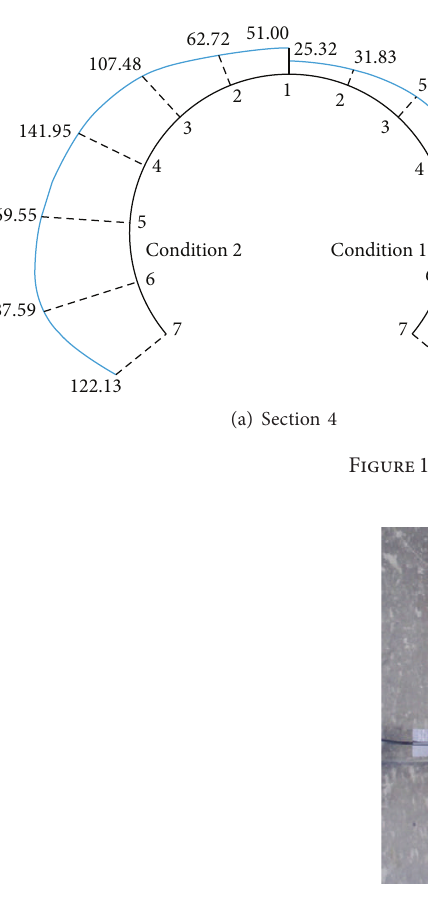
Figure 16: On-site monitoring